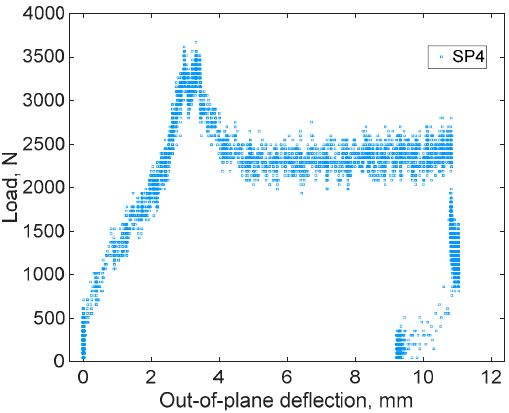
Figure 5. Out-of-plane displacement of Wall 1.